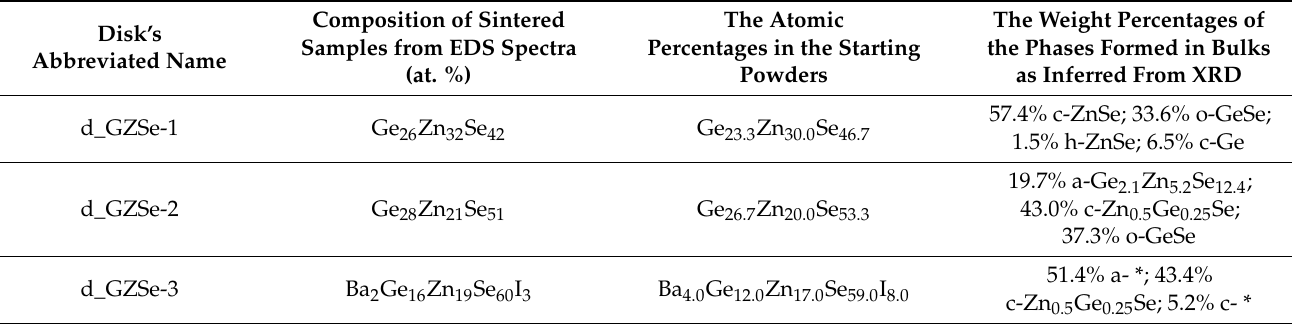
Table 4. The elemental EDS composition (at. %) of the sintered samples as compared with the starting powders. In addition, the computed weight percentages of the crystalline phases of the bulk samples inferred from XRD are included for comparison (the unidentified amorphous and crystalline phases are denoted with